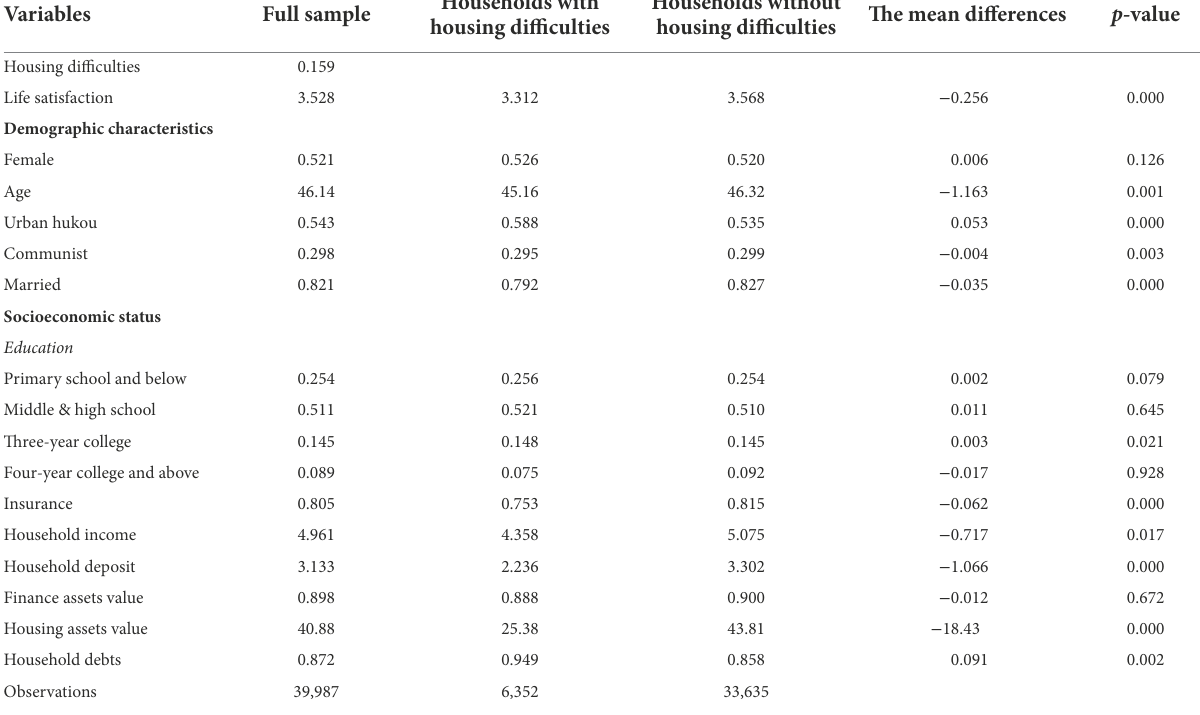
TABLE 1 Summary